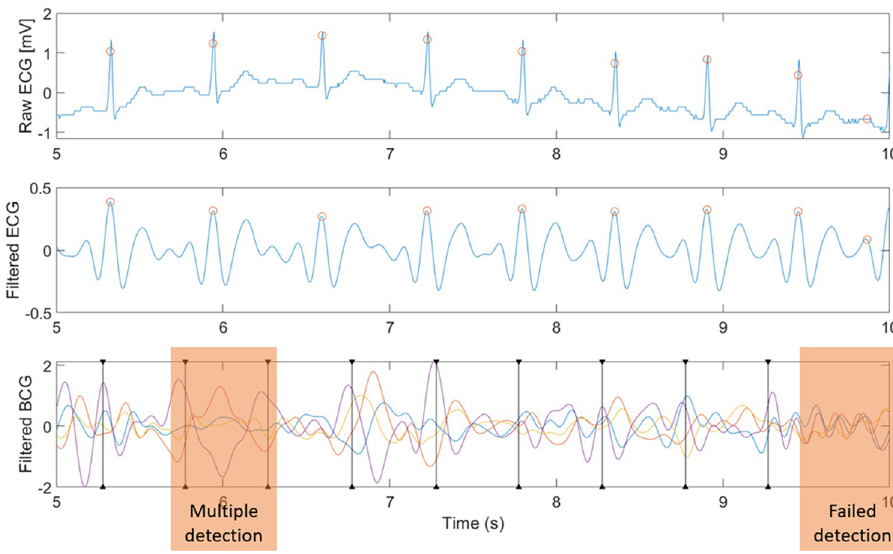
Fig 9. An example of detection of R-peaks directly after the exercise period; The orange boxes note indicate failures in peak